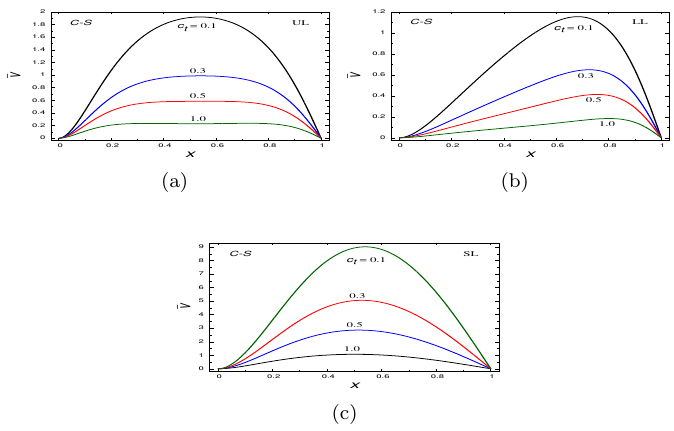
Figure 7. Effect of viscous damping parameter c t on the distribution of angular displacement along the axial direction of a C-S CNT subjected to: (a) UL, (b) LL, and (c)